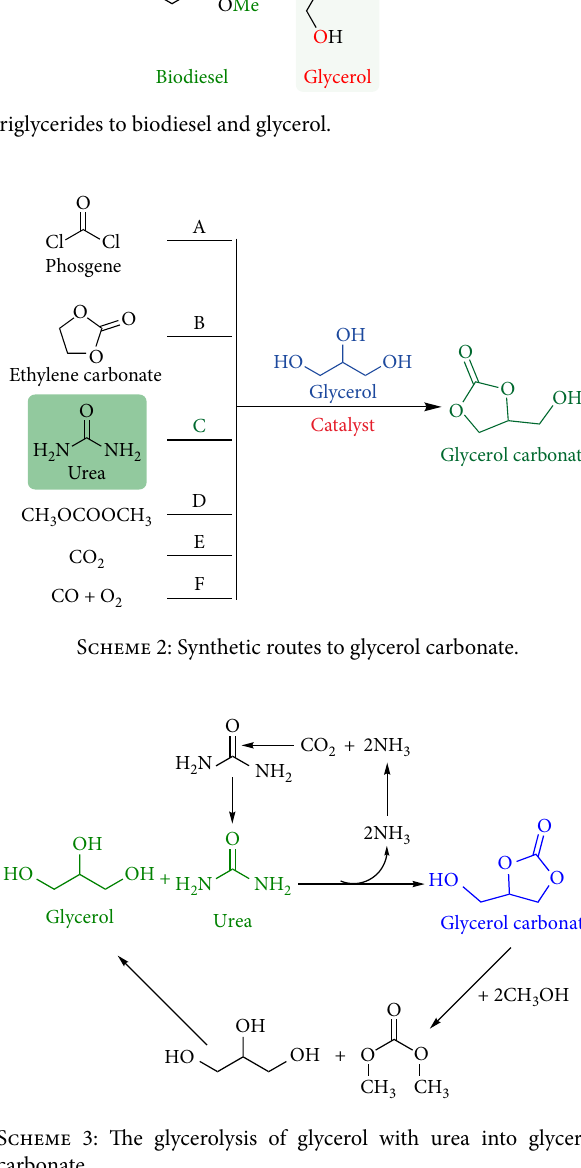
Scheme 3: The glycerolysis of glycerol with urea into glycerol